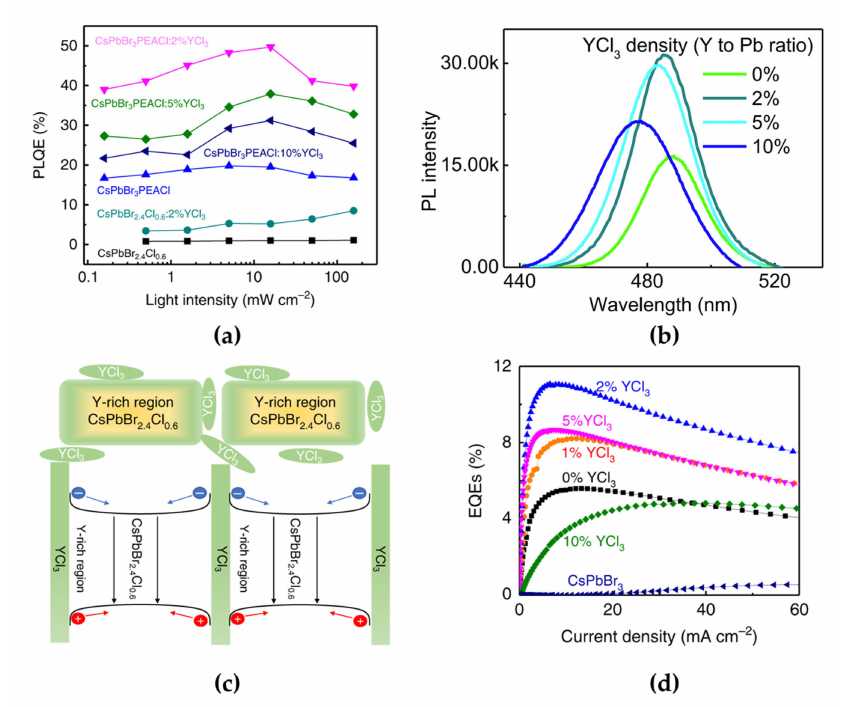
Figure 7. ( a ) Laser-power-dependent PL quantum efficiencies (PLQEs) of perovskites with different compositions. ( b ) PL spectra of CsPbBr 3 :PEACl (1:1) films with different YCl 3 ratios. The PL peak positions are at 487 nm (0% YCl 3 ), 485 nm (2% YCl 3 ), 483 nm (5% YCl 3 ), and 477 nm (20% YCl 3 ). ( c ) Schematic of Y distribution in the CsPbBr 3 :PEACl (1:1) film and its bandgap around the